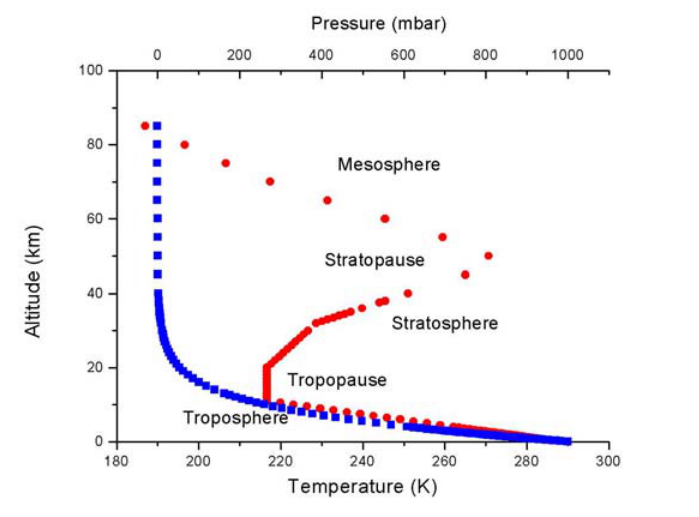
FIGURE 1 . Pressure (mbar, blue (cid:132) ) and temperature (K, red (cid:122) ) profiles for Earth's atmosphere (1976 standard atmosphere